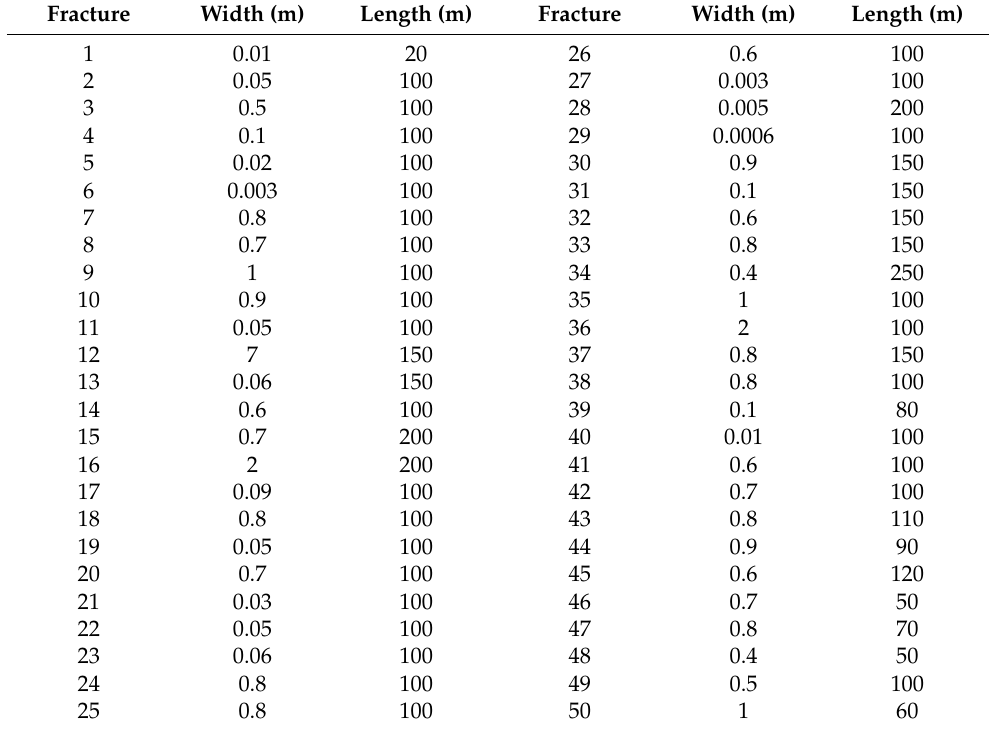
Table 6. Parameters given for Figure